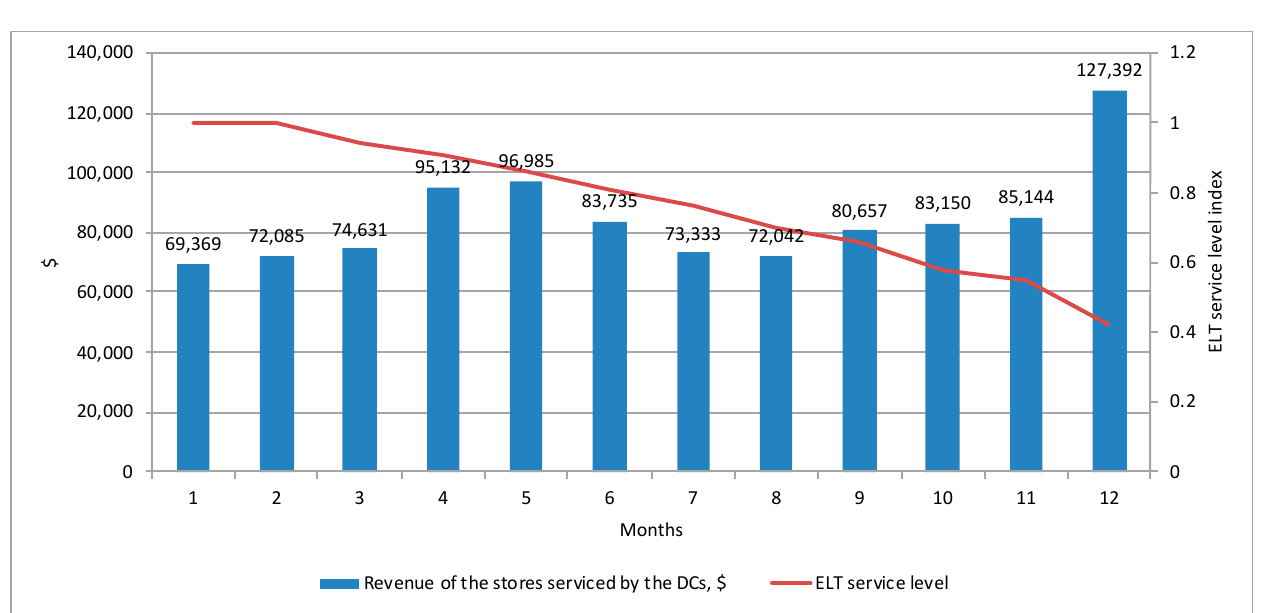
Figure 1. Revenue dynamics of serviced stores and the level of ELT order servicing. The processing time of some orders by the DC varies from 1 to 7 days and increases the number of delayed deliveries of products. The speed of order collection is very low compared to orders received from stores.